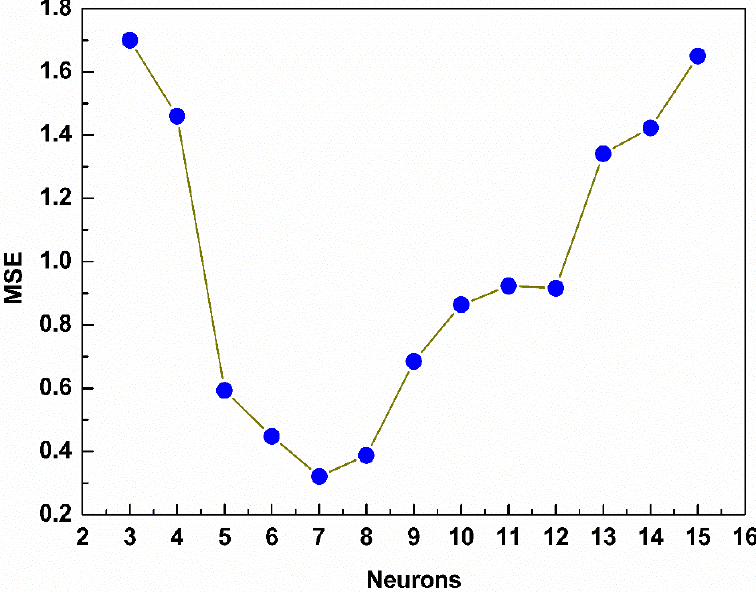
Figure 1. Optimization comparison diagram of the number of hidden layer neurons. MSE: Mean square error.